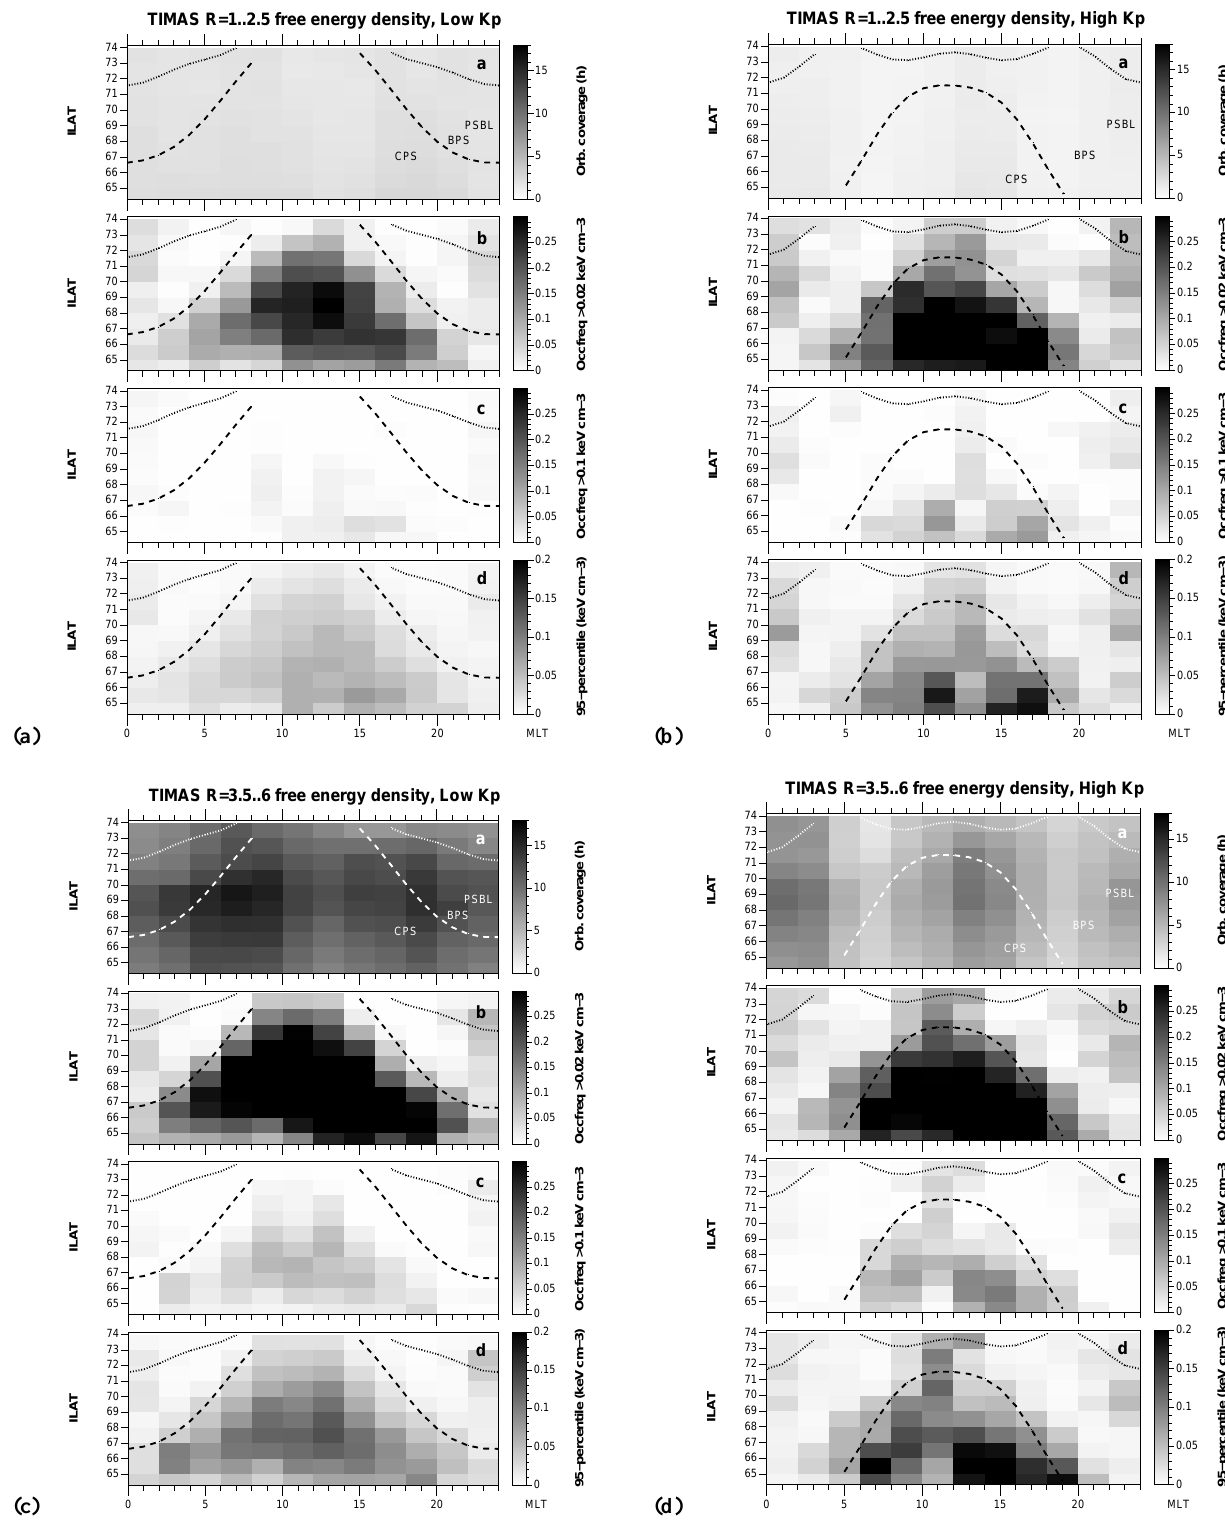
Fig. 1. Ion free energy by Polar/TIMAS as a function of MLT and ILAT for K p ≤ 2 (left subplots) and K p > 2 (right subplots). Top plots show include radial distances 1–2.5 R E , bottom plots 3.5–6 R E . Orbital coverage in hours in each MLT and ILAT bin (a) , fraction of time the free energy exceeds 0.1keVcm − 3 (b) , fraction of time the free energy exceeds 0.02keVcm − 3 (c) , 95-percentile of free energy density (d) . Some black regions are saturated. The dashed/dotted line is the Holzworth-Meng model auroral oval equatorward/poleward boundary for Q = 1 . 65 (low K p ) and Q = 6 (high K p ) (Holzworth and Meng,